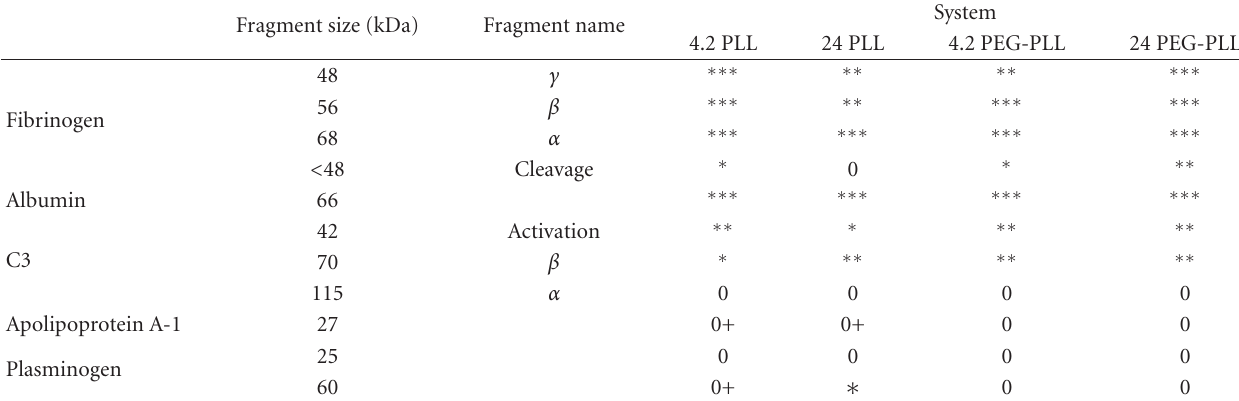
Table 2: BSA NP plasma adsorption conditions and results as evaluated with